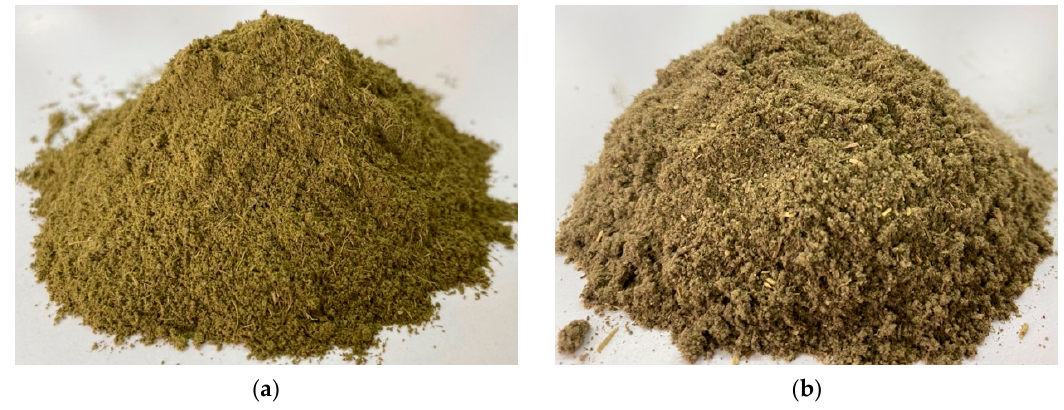
Table 1. Silicone properties [36].